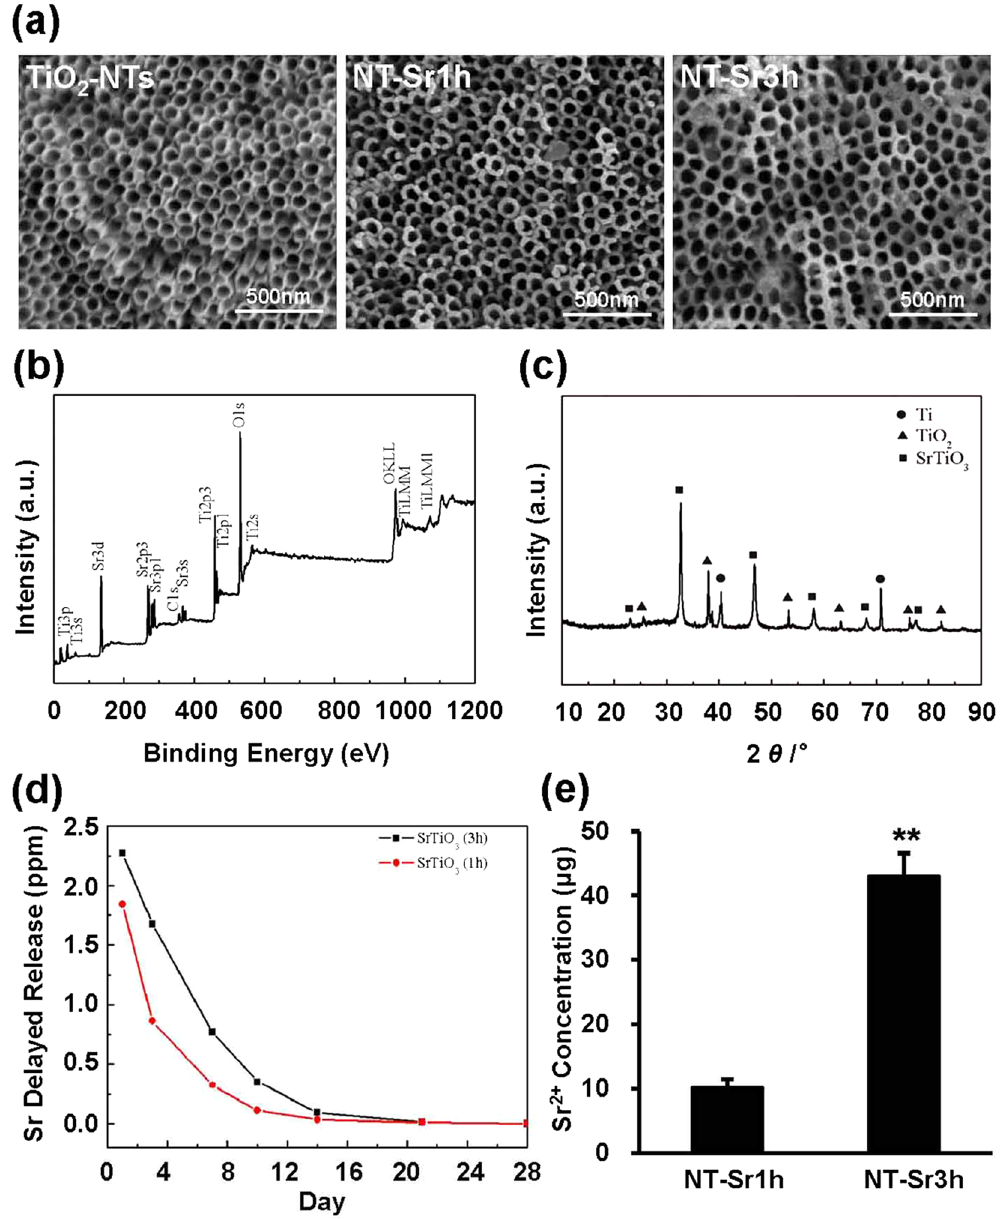
Figure 1. Microstructure and surface chemistry characterisation of the samples. ( a ) FE-SEM images of TiO 2 -NT, NT-Sr1h, and NT-Sr3h. The scale bar represents 500 nm. ( b ) XRD pattern of NT-Sr1h. ( c ) XPS survey spectra of NT-Sr1h. ( d ) Release of Sr from NT-Sr1h and NT-Sr3h into PBS at different time points. ( e ) Total Sr content of NT-Sr1h and NT-Sr3h, ** p < 0.01. At least three independent experiments were analysed, and the data are presented as the means ±